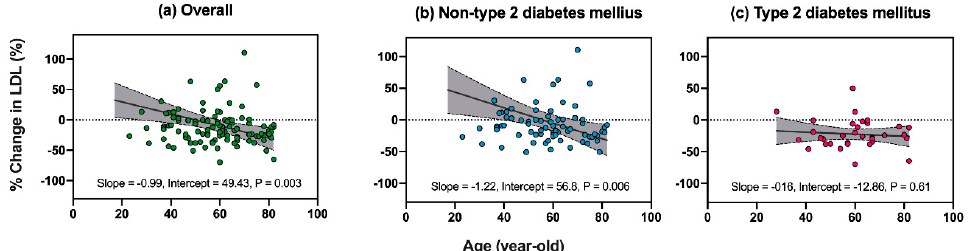
Figure 4. Correlations between age and % change in LDL-C. The Pearson correlation coefficient is used to calculate slope (solid lines) with 95% confidence interval (dotted lines). Table 2. Univariate and multivariate linear regression analyses to identify factors associated with% change in